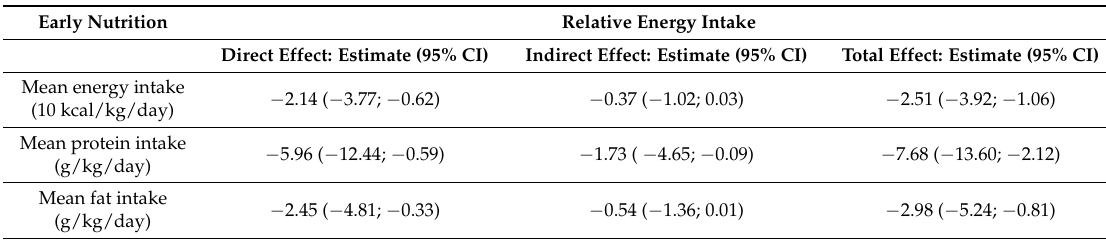
Table 5. Model 4: Path from weight SD score at nine weeks age to outcome fixed as 0 (i.e., b7 = 0). Tested against Model 4. Model 5: Path from nutritional intake from the first three weeks of life to outcome fixed as 0 (i.e., b1 = 0). Tested against Model 5. Table 5. Model derived effect estimates with 95% bias corrected confidence intervals for relative energy intake in adult